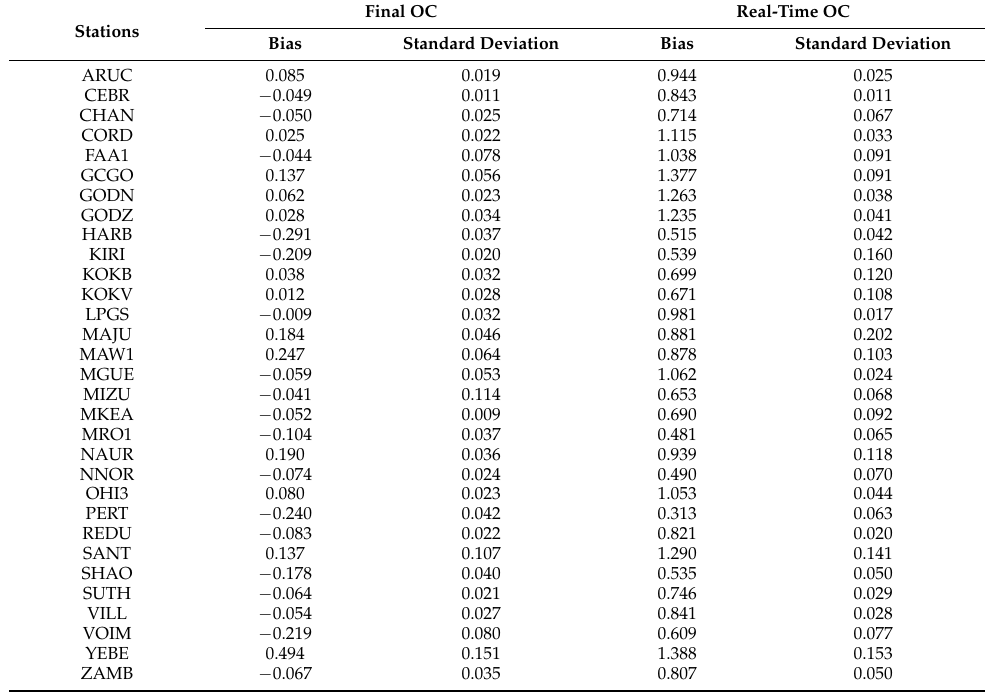
Table A3. Statistics of Figure 12. GF-GB ionospheric delays for PRN 09 for all sites, GB ionospheric delays are derived from final OC and real-time